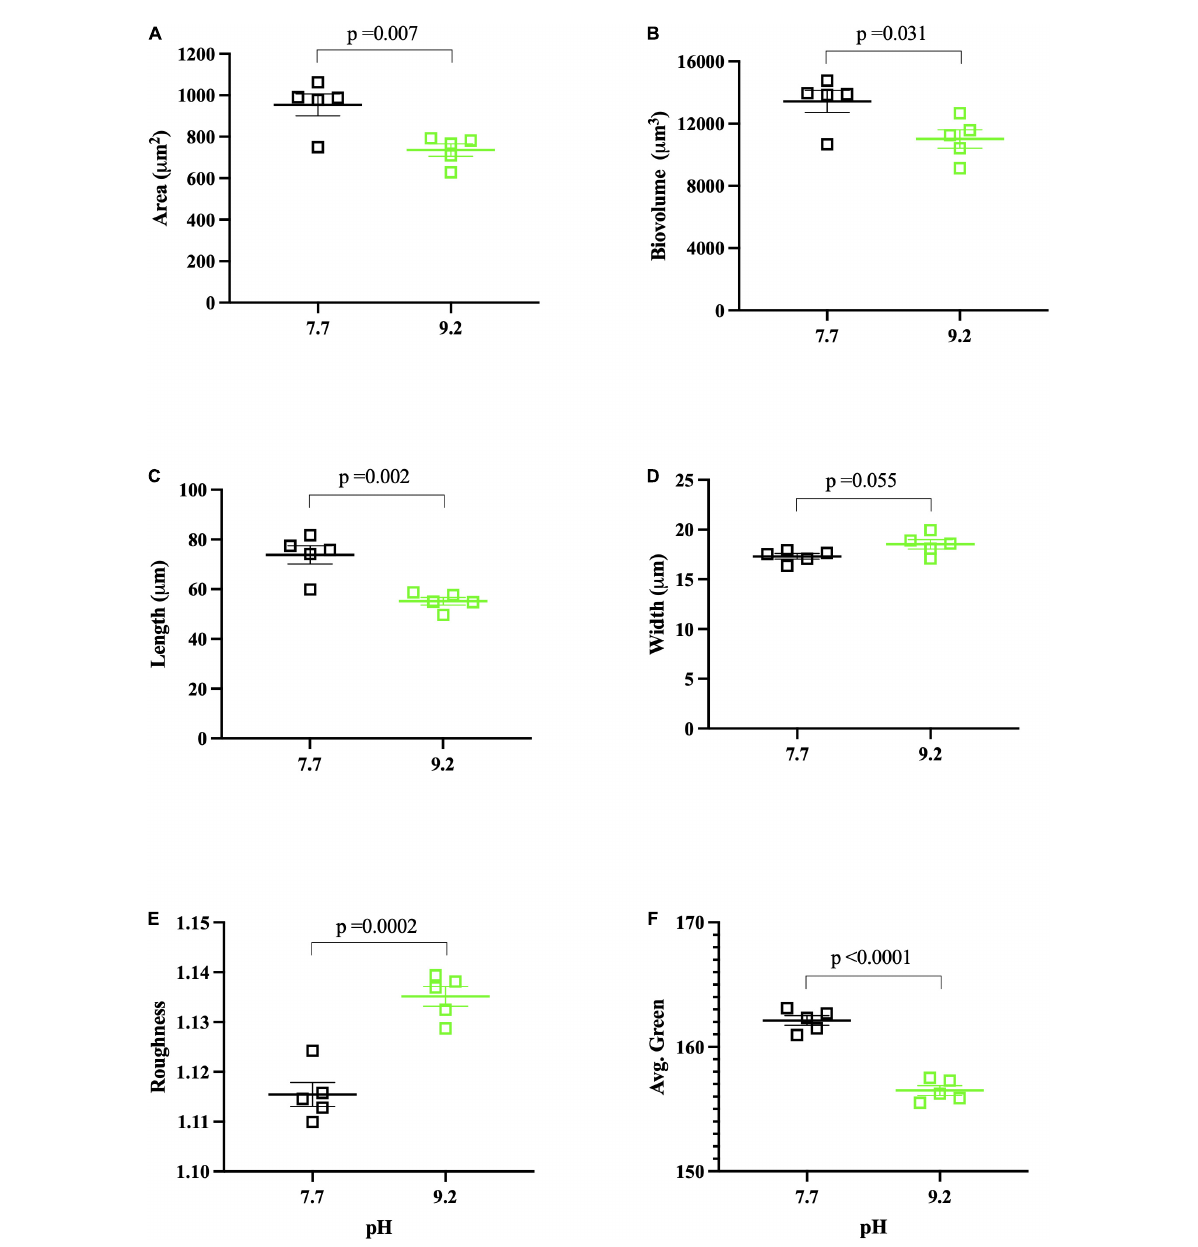
FIGURE2 FlowCAM pH assay results collected at (T f ). pH 7.7 replicates denoted by open, black squares. pH 9.2 replicates denoted by open, green squares. Each data point represents the mean of ∼ 1000 filaments per biological replicate, with the group mean of treatment replicates indicated by the central bar, and variability indicated by error bars representing the standard error of the mean (SEM). Variance for individual dots is reported in Supplementary Data Sheet 2 . (A) Mean area ( µ m 2 ) of F. crotonensi s filaments. (B) Mean biovolume ( µ m 3 ) of F. crotonensi s filaments. (C) Mean length ( µ m) of F. crotonensi s filaments. (D) Mean width ( µ m) of F. crotonensi s filaments. (E) Mean roughness (dimensionless) of F. crotonensi s filaments. (F) Mean green coloration of F. crotonensi s filaments (dimensionless). P -values are for comparisons between